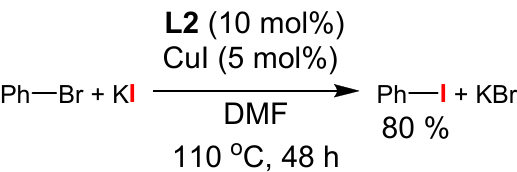
Figure 1. Structures of ligands used for aromatic Finkelstein reaction